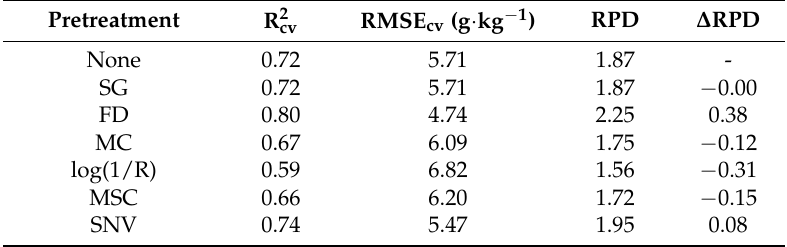
Figure 7. A subset of 14 samples selected based on raw and pretreated spectra. The gray ellipse shows the major difference in sample selection between raw and pretreated spectra. Table 3. Cross-validation of applying pretreatments to multivariate regression analysis for estimating soil organic matter (SOM).